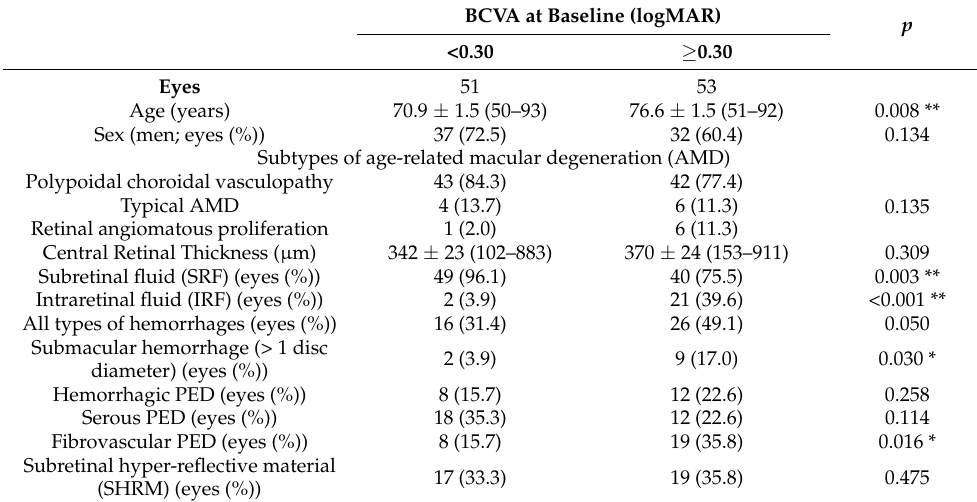
Table 5. Characteristics of patients with better best-corrected visual acuity (BCVA) (< 0.3 in logMAR) at